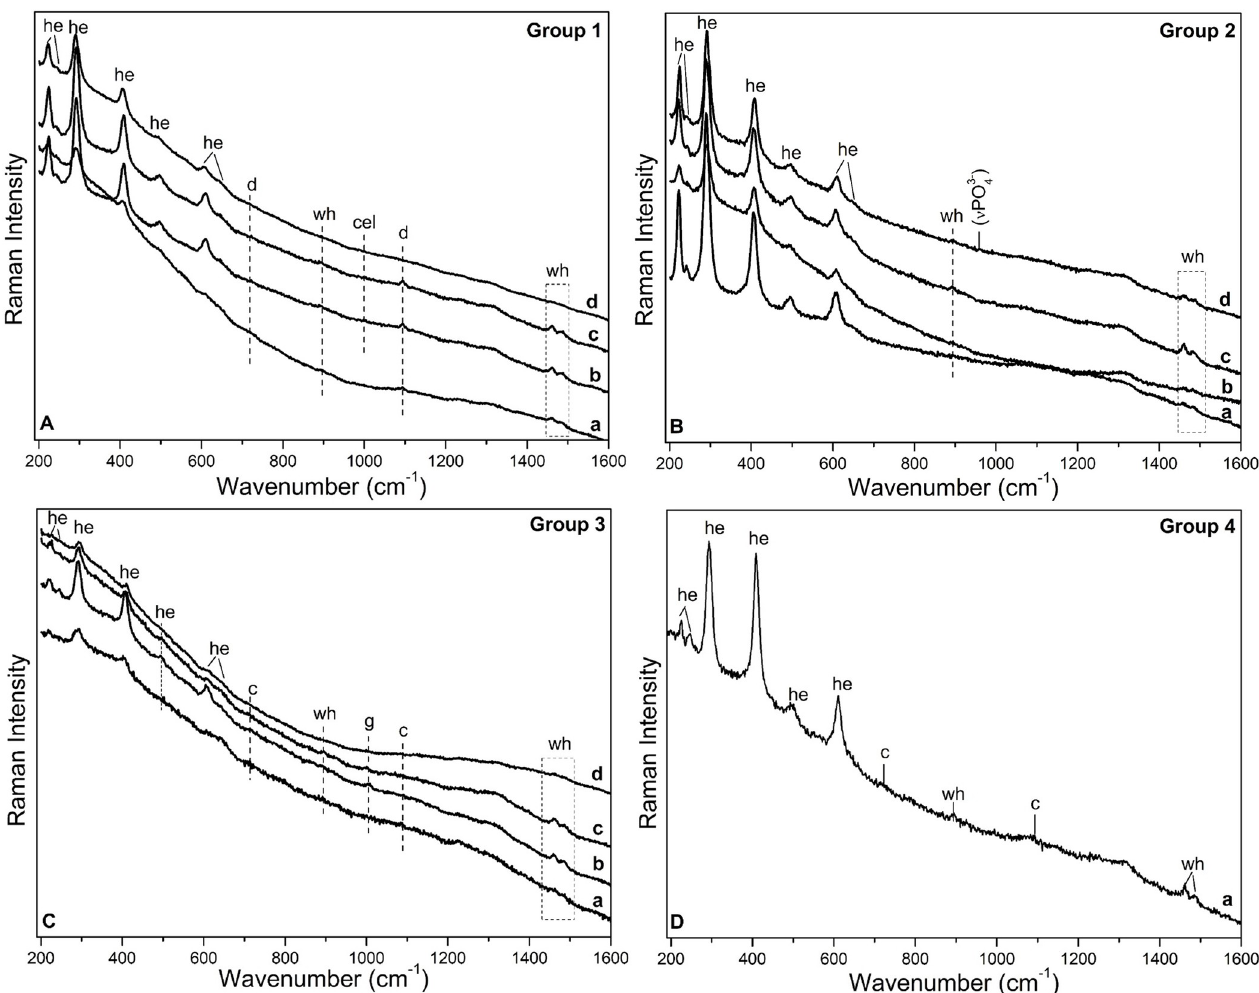
Fig 7. Representative Raman spectra ( λ exc = 785 nm) acquired in the pictorial layers of the cross-sections belonging to A) group 1 (line a = AC2.2, line b = AC2.1, line c = AC3 top , line d = AC5.1); B) group 2 (line a = AC1 top , line b = AC4, line c = AC5.2 and line d = AC8); C) group 3 (line a = AC1 bottom , line b = AC3 bottom , line c = AC6 and line d = AC9); D) group 4 (line a = AC7). Legend: he = hematite; d = dolomite; wh = whewellite; cel = celestite; c = calcite; ( ν PO 4-3 ) = phosphate group assigned to